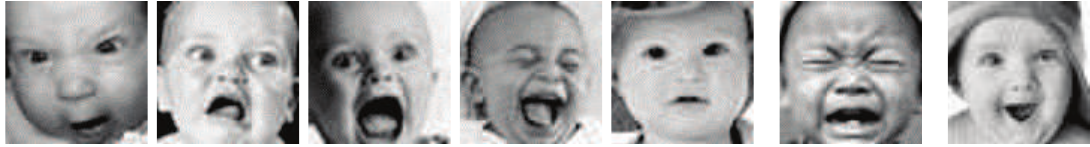
Figure 12. Examples of images in the FER-2013 database. The emotions from left to right are: anger, disgust, fear, happy, normal, sadness and